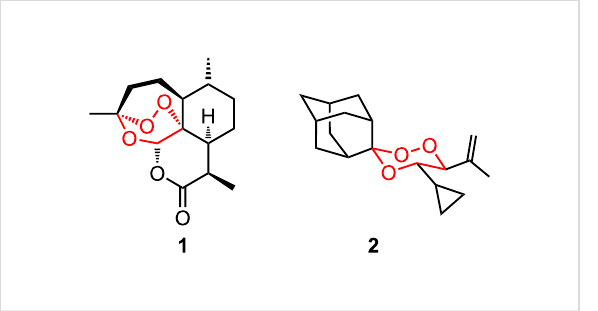
Figure 1: Antimalaria active natural artemisinin 1 and the spirobicyclic 1,2,4-trioxane derivative 2 show the same in vitro activity.